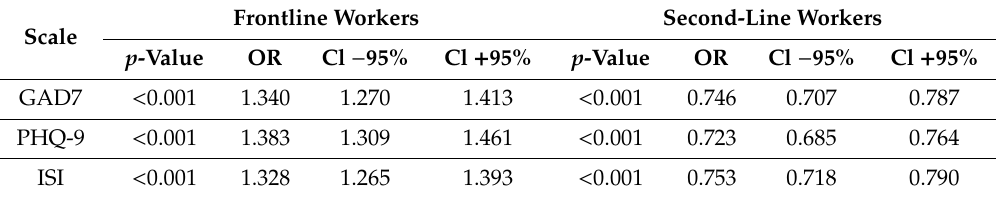
Table 2. Univariable logistic regression model among frontline and second-line healthcare workers.